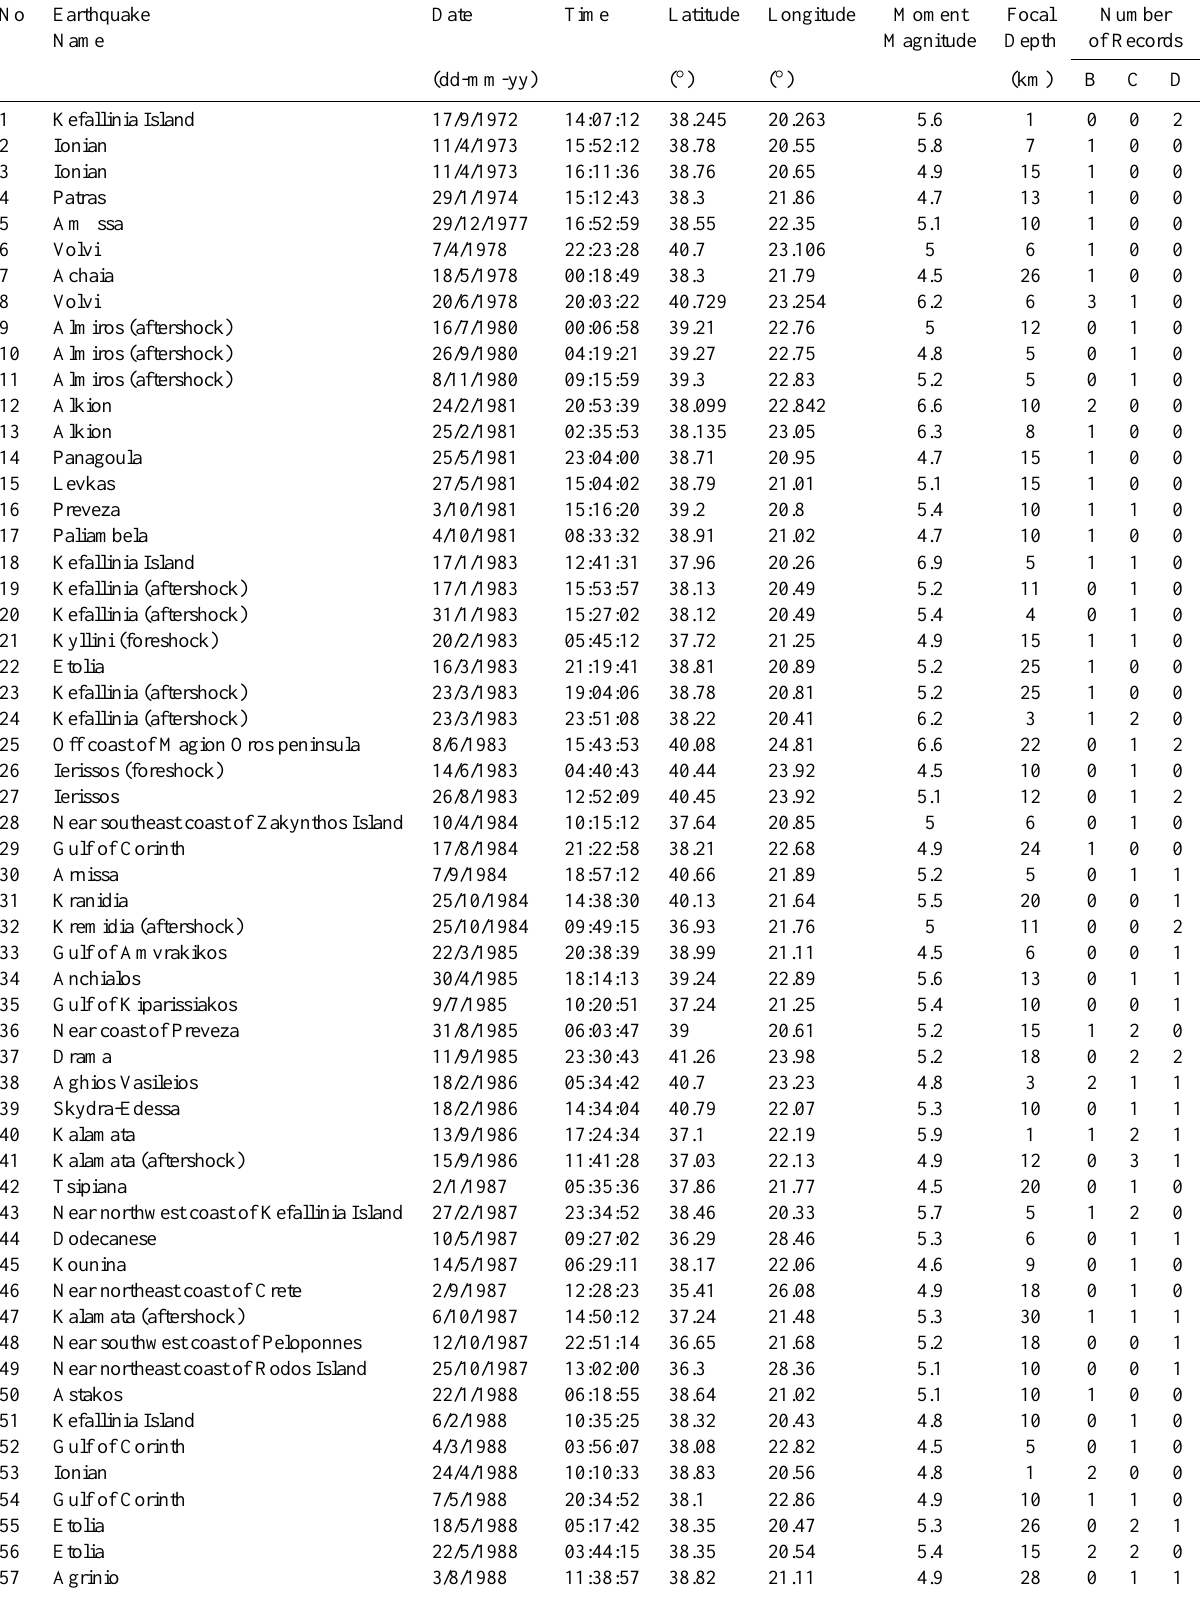
Table 1. Database of strong motion records